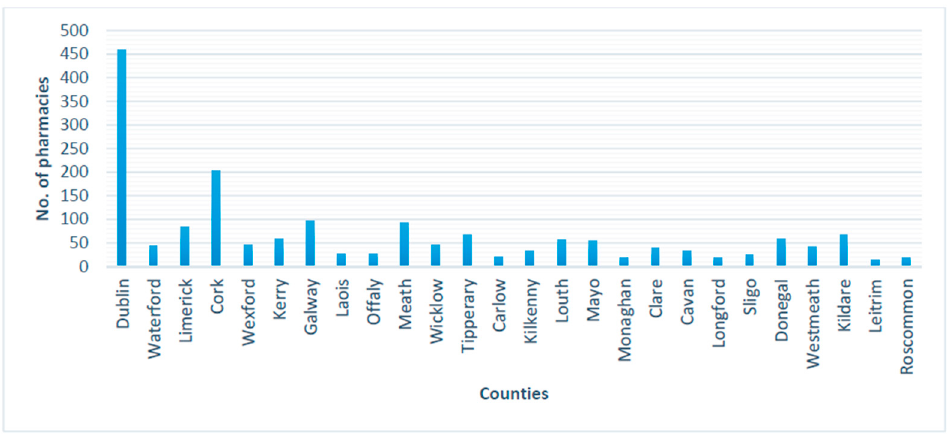
Figure 11. Plot showing county wise pharmacy list from Ireland.